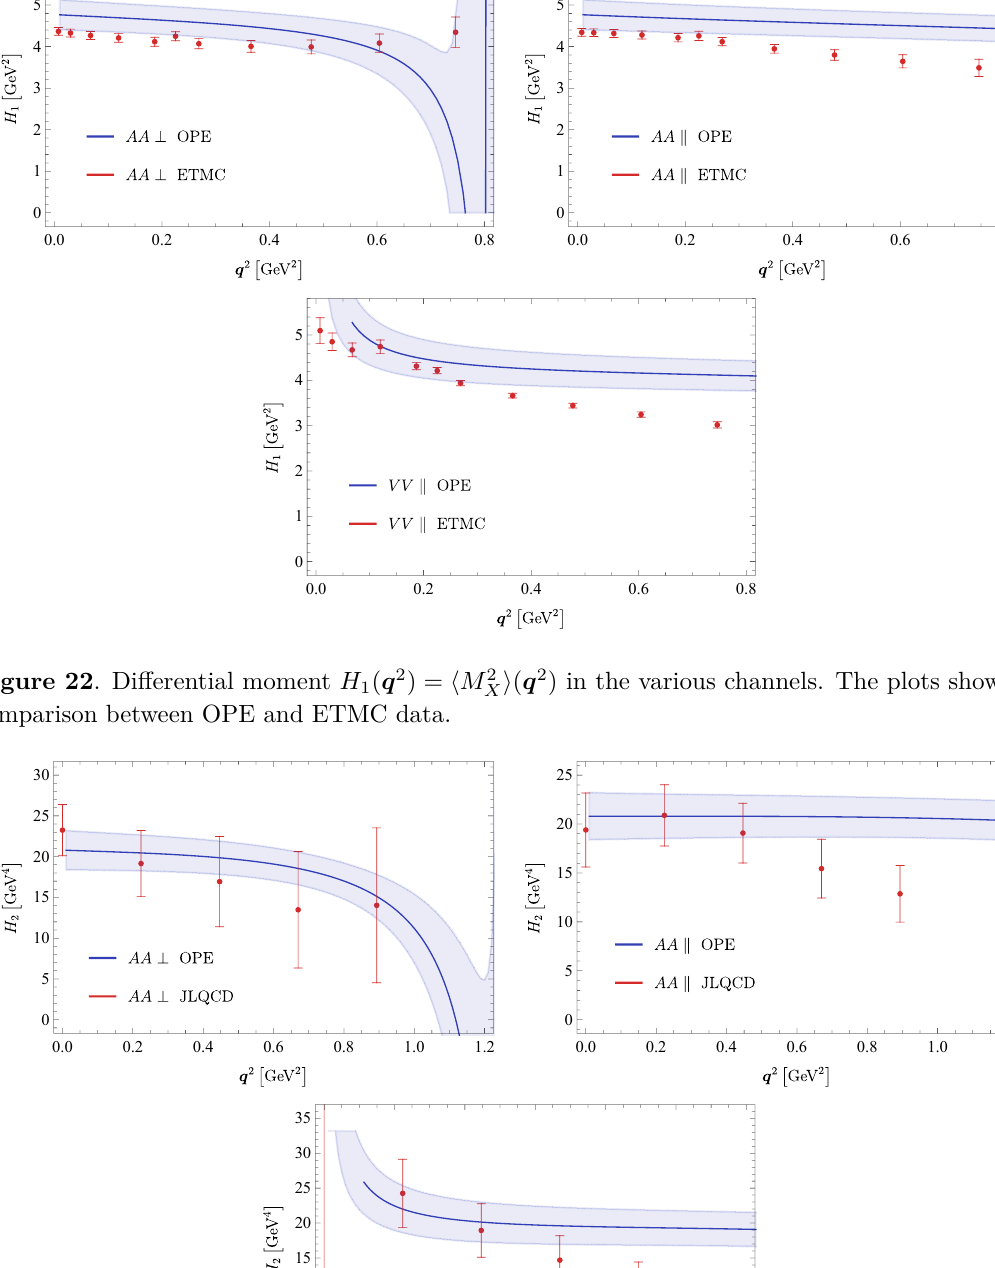
Figure 23 . Differential moment H 2 ( q 2 ) = h M 4 comparison between OPE and JLQCD